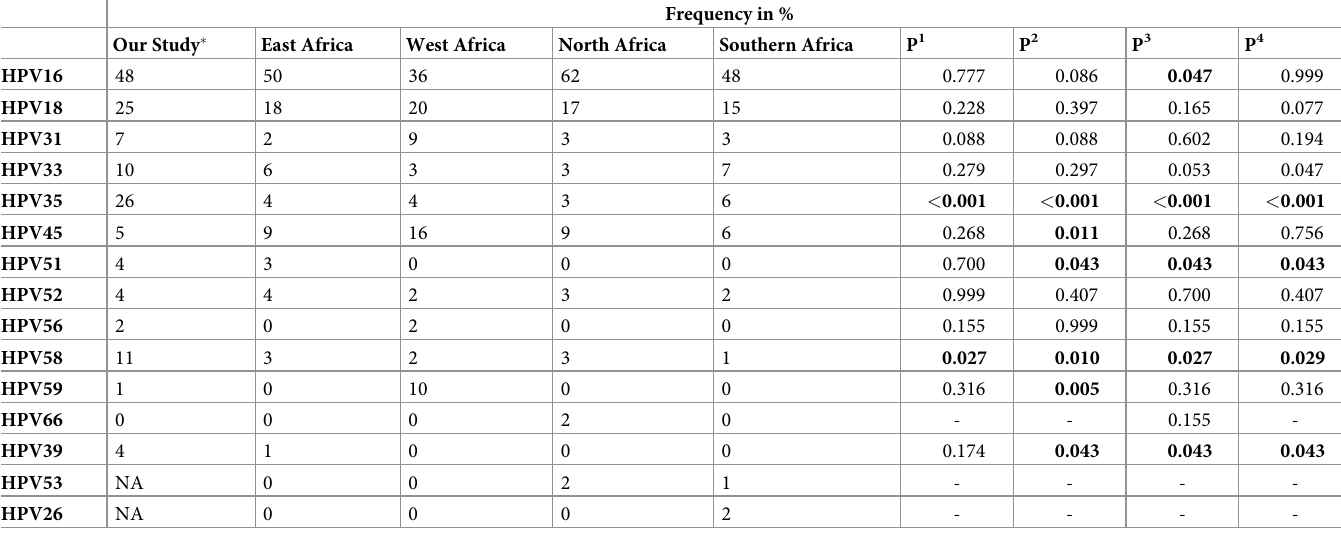
Table 4. Comparison of the frequencies of the most common HPV genotypes reported across